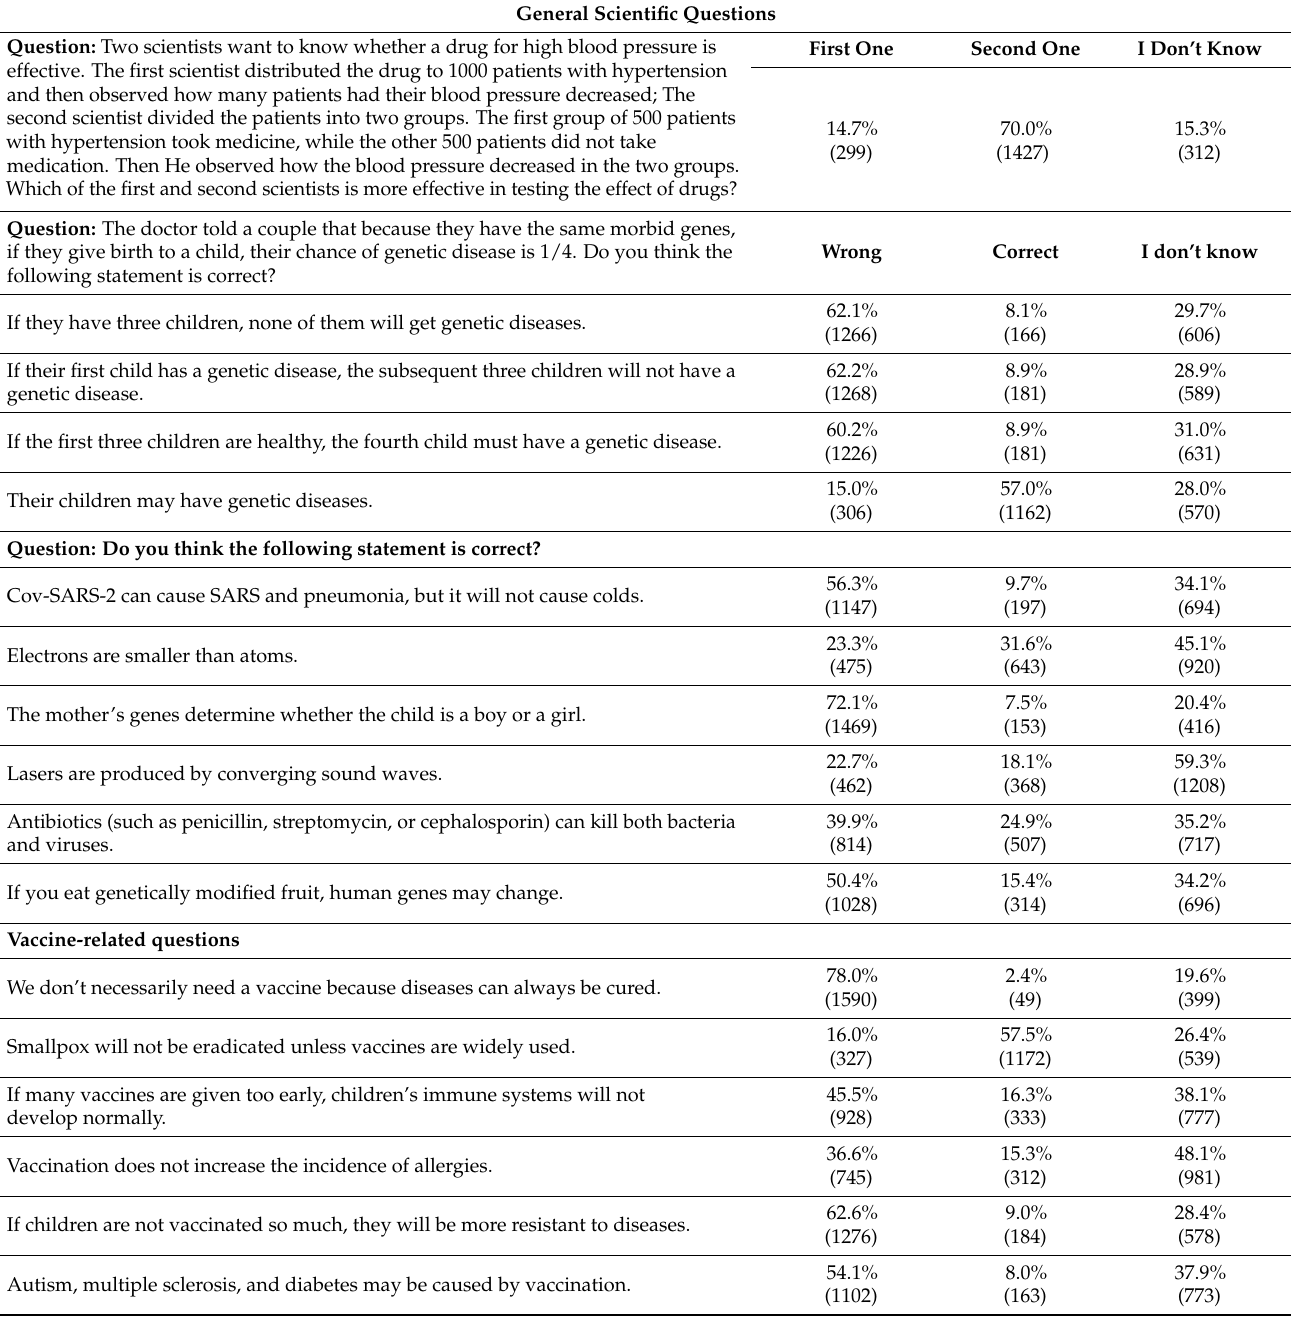
Table 3. Participants’ scientific literacy and knowledge about vaccine ( n =